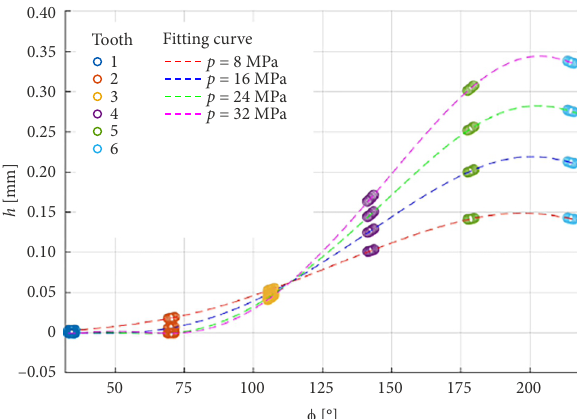
Figure 9. Height of the circumferential gap as a function of an angle of rotation of pump shaft for the driving gear together with the fitting curves